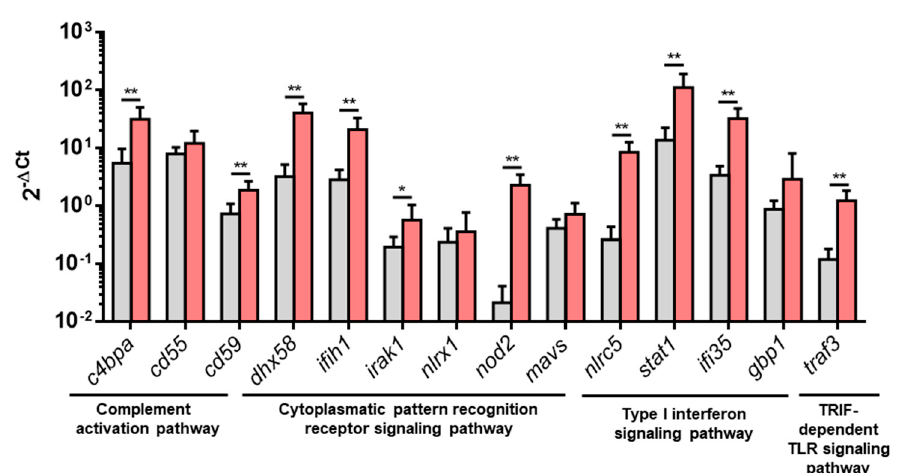
Figure 5. Upregulated DEGs from overrepresented pathways analyzed by RT-qPCR. Gene expression of PB-RBCs from VHSV-challenged rainbow trout (red bars) compared to the control, mock-challenged fish (gray bars) at 2 dpc. Data represent mean ± SD ( n = 6). A Mann–Whitney test was performed to test statistical significance between PB-RBCs from both groups. Asterisks denote statistical significance. * p -value < 0.05; ** p -value < 0.01.